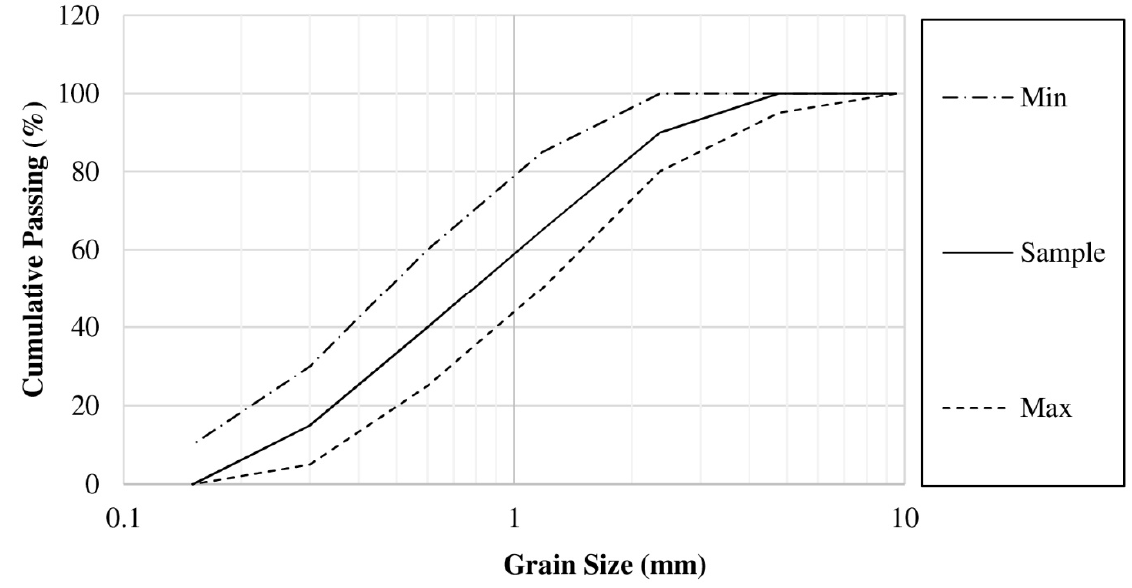
Figure 3. Particle size distributions of the reactive fine aggregate used in this study.